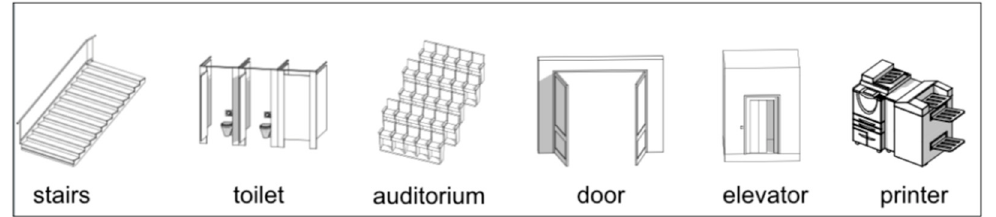
Figure 16. Axonometric-based landmarks.